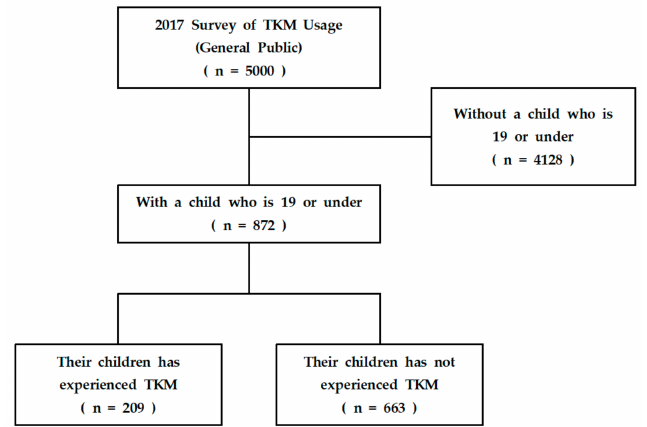
Figure 1. Flow chart of inclusion and exclusion of participants from the 2017 National Survey of Traditional Korean Medicine Usage. TKM: Traditional Korean